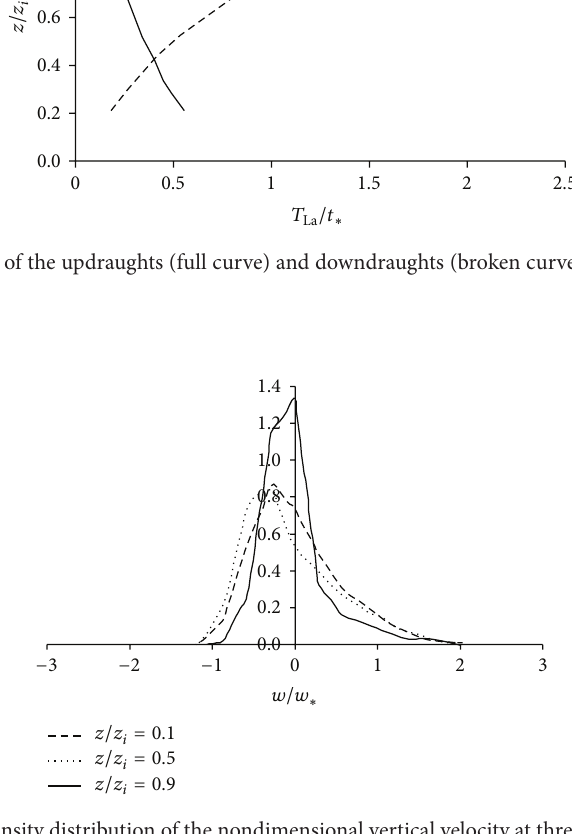
Figure 12: Probability density distribution of the nondimensional vertical velocity at three nondimensional